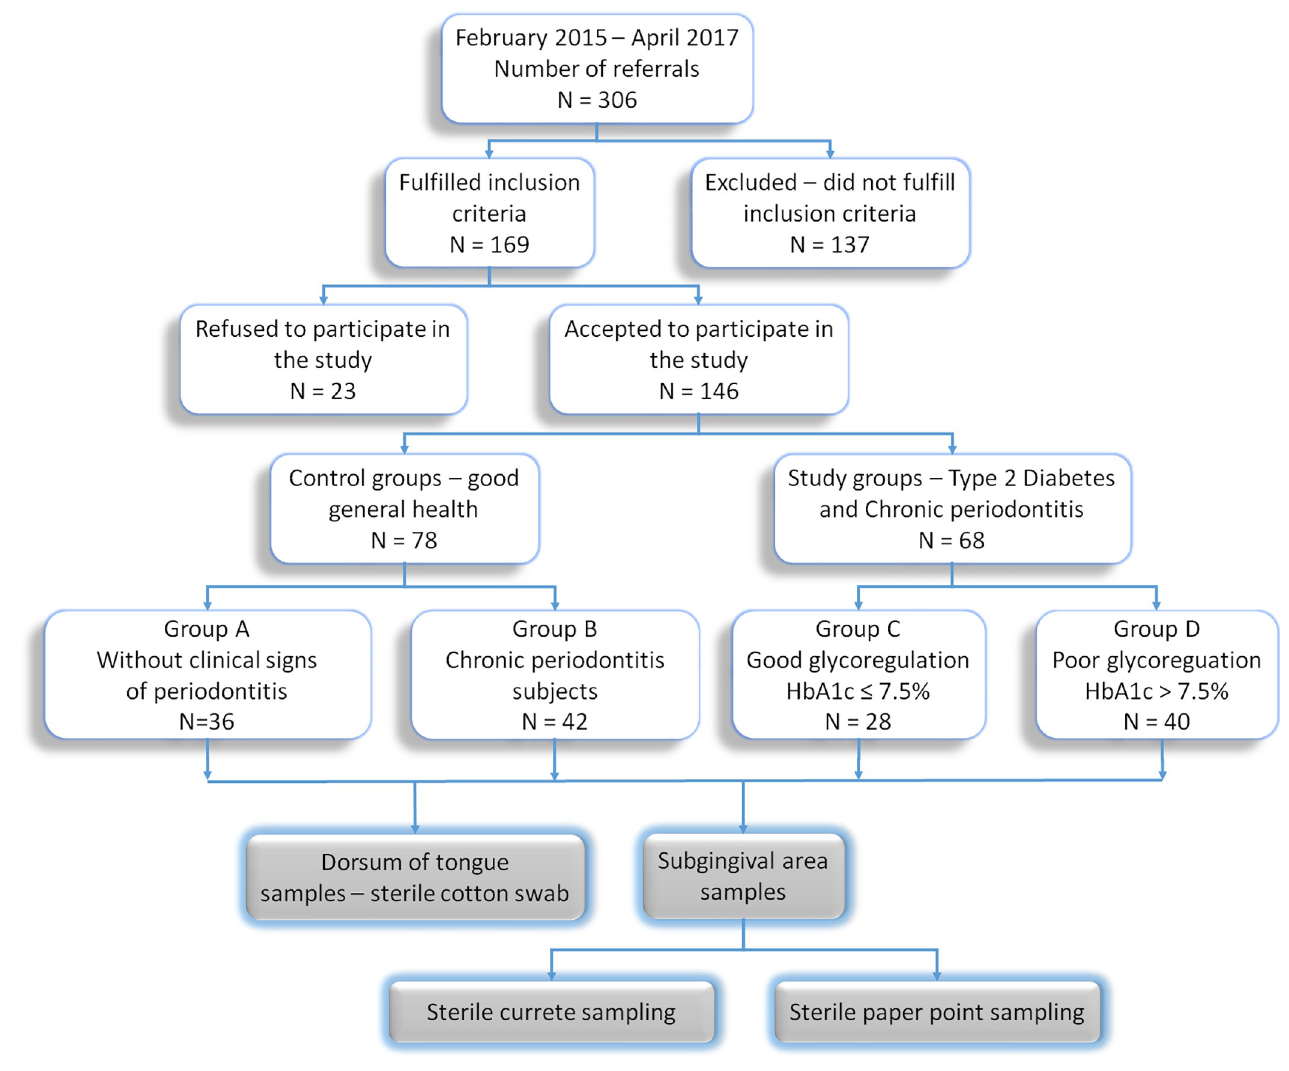
Fig 1. Study and subject